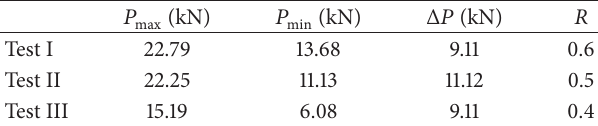
Table 1: Loading conditions related to Ghonem and Dore tests.